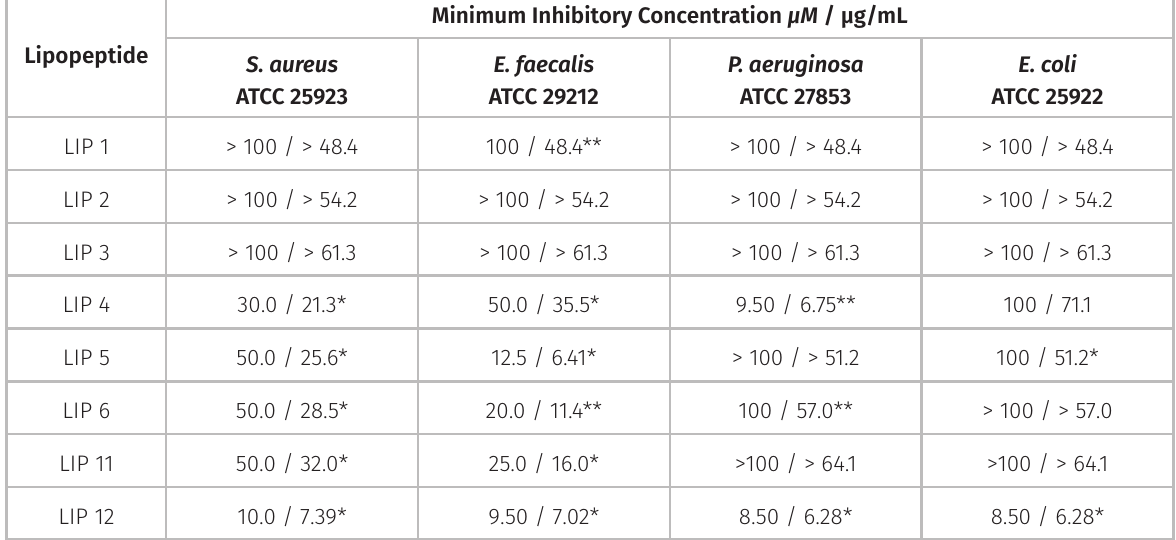
Table II. Antimicrobial activity of de novo designed short cationic lipopeptides. Minimum inhibitory concentrations (MICs) in micromolar concentrations and µg/mL and bactericidal/bacteriostatic effects.